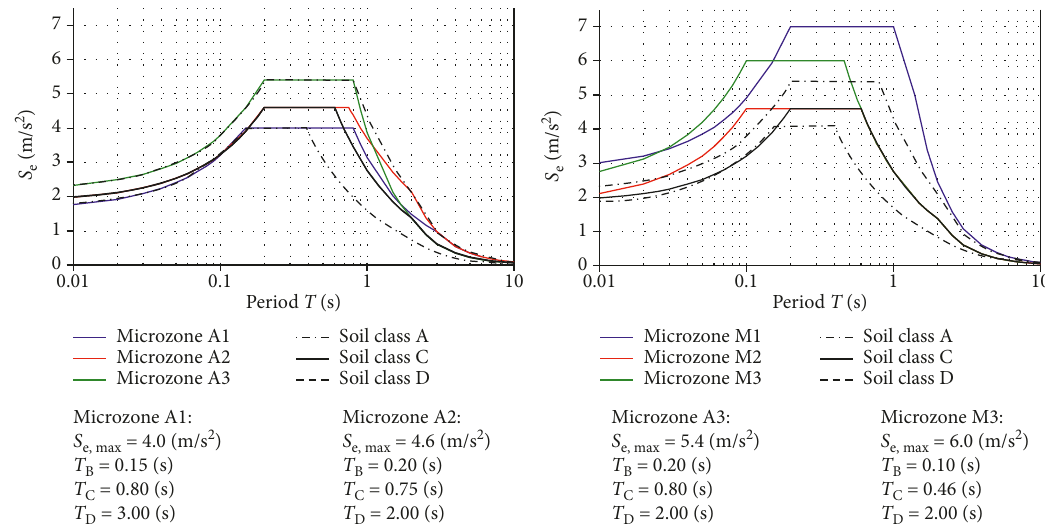
Figure 4: Microzonation of Sion and Martigny: elastic response spectra for a return period of 475years and 5% damping ratio related the six microzones A1, A2, and A3, respectively, M1, M2, and M3